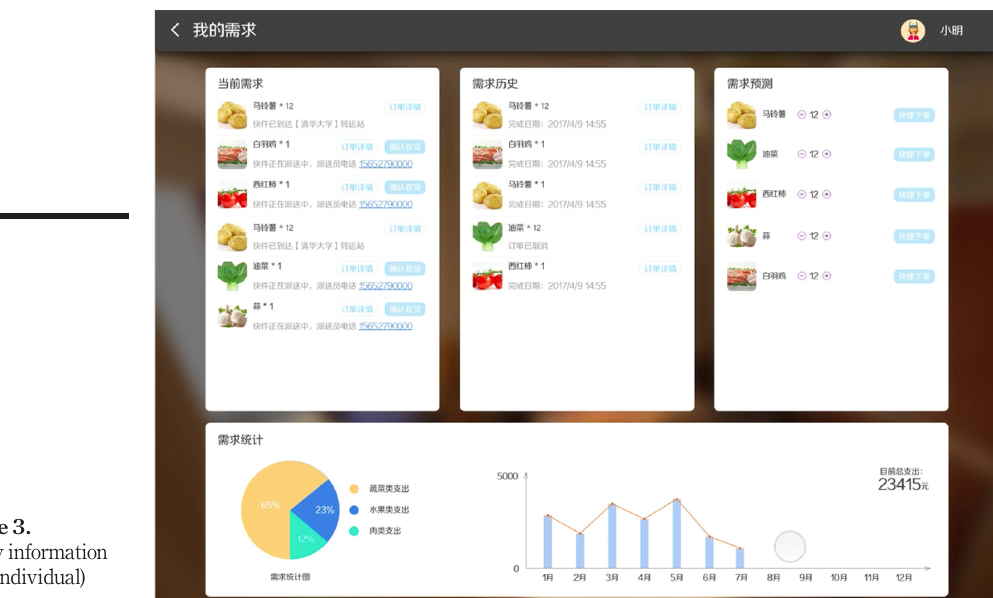
Figure 3. Supply information